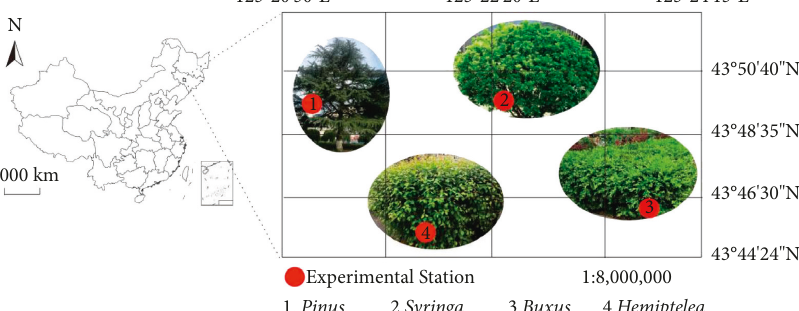
Figure 1: Location of the sample